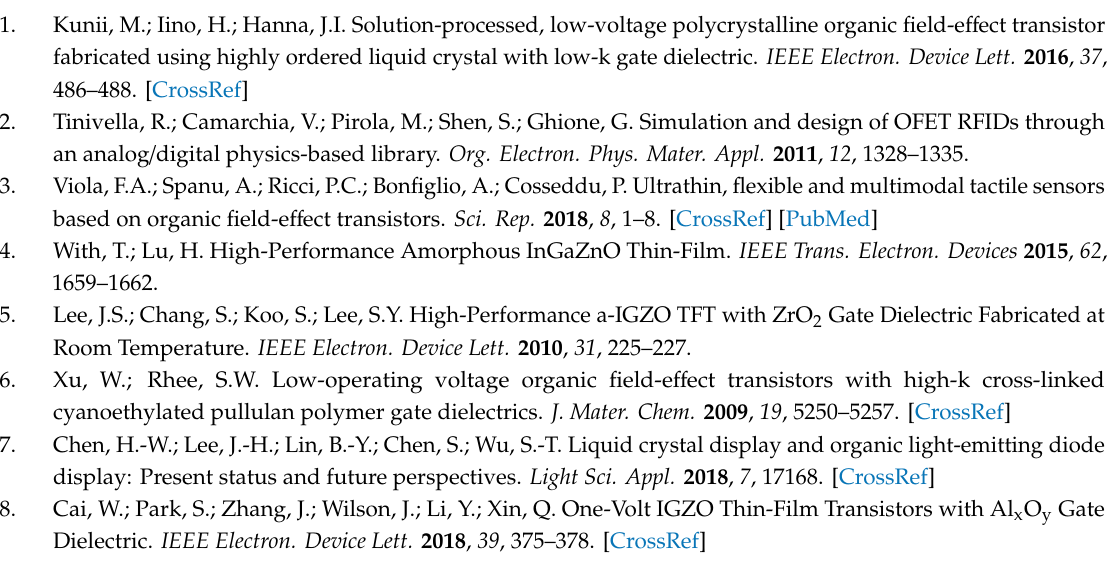
Figure S1: Normalized peak fitted Ta 4d spectra for both control and anodized regions of the sample showing only Ta oxide in the anodized region relative to a metal / oxide mixture in the control region. Figure S2: Normalized O 1s spectra for both control and anodized regions. Figure S3: Normalized Ta 4f spectra for both control and anodized